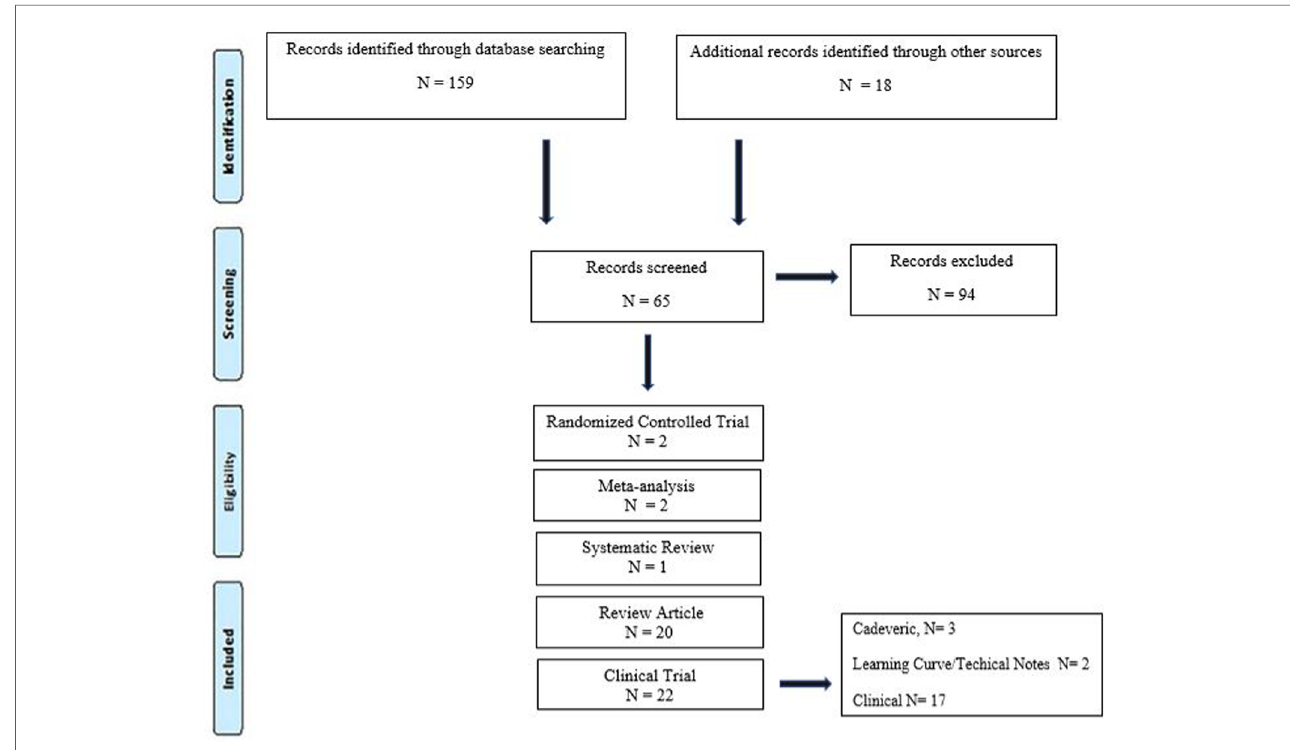
FIGURE 1 PRISMA fl ow diagram for the systematic review detailing the database